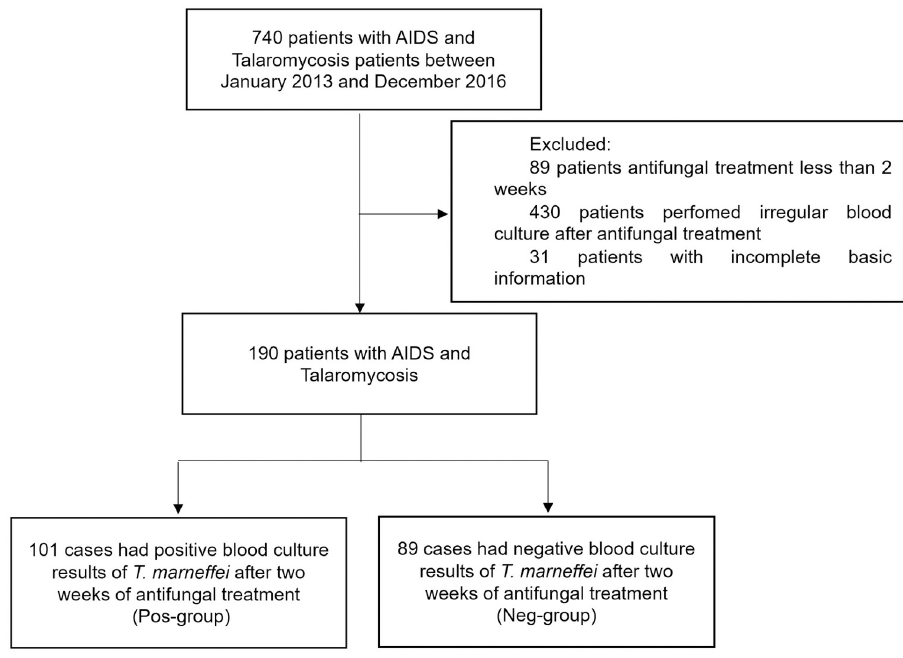
Fig 1. The subject disposition in the